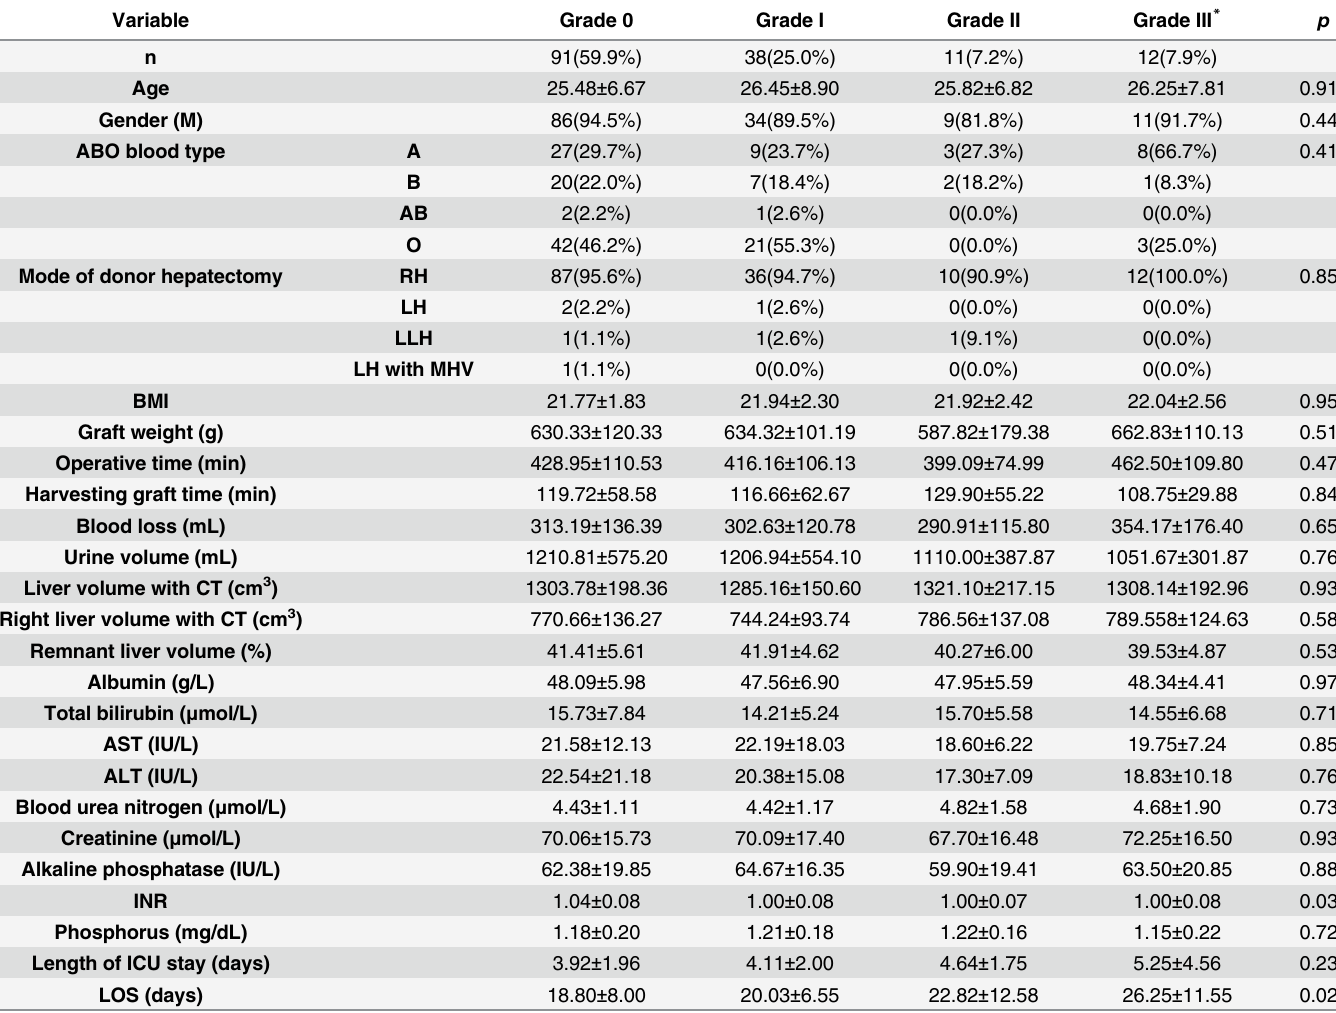
Table 4. Comparison of pre-operative and operative variables between different grades of